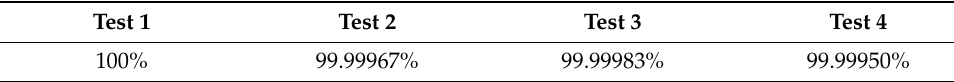
Table 3. Efficiency 2 : Results from four tests for the graph